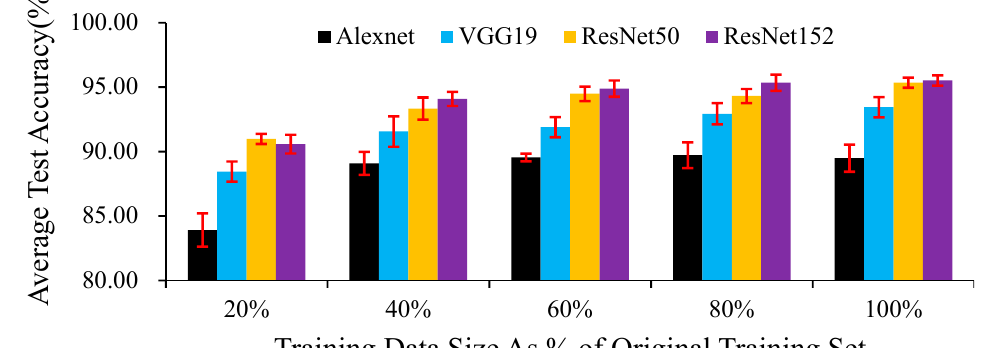
Figure 9. Average test accuracies of the proposed models trained with training sizes ranging from 20% to 100% of the images in the original training set. Error bars displaying the standard deviations within 50 epochs are shown.